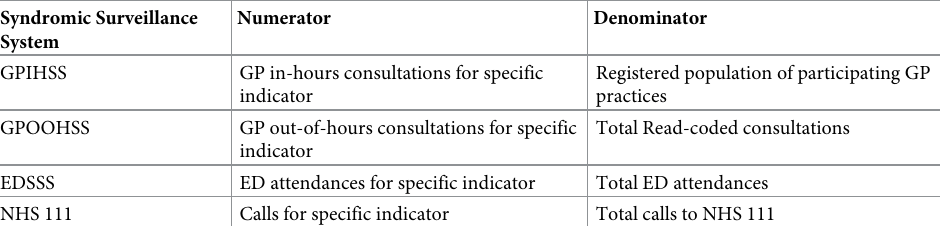
Table 1. Methods for calculating syndromic indicator rates for syndromic